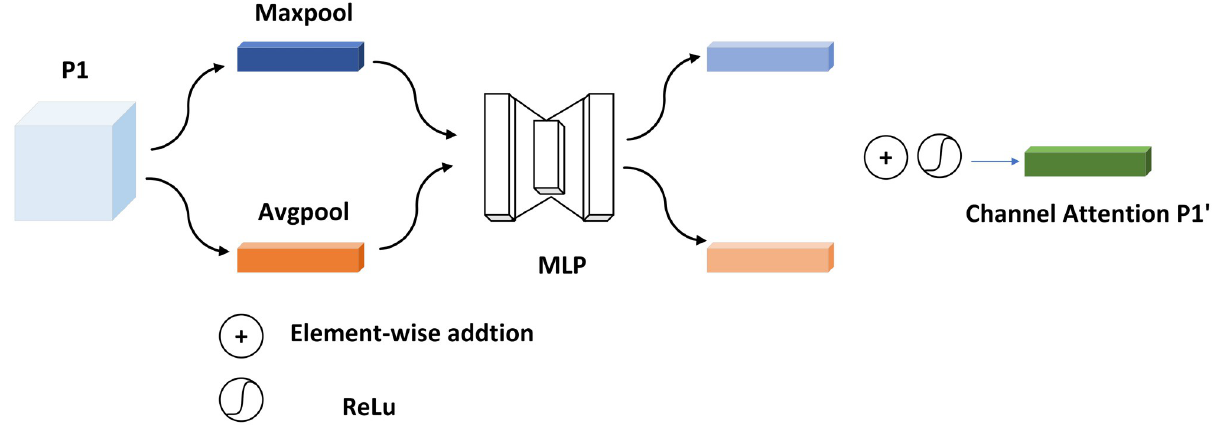
Fig 5. Channel attention module structure.